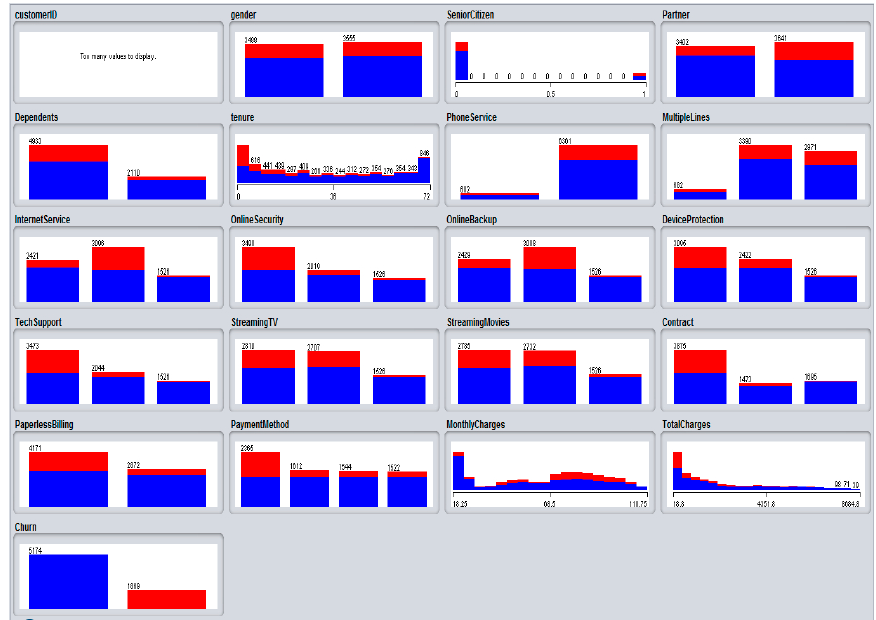
Figure 2. The distribution of attributes in churn dataset; Here red indicates churn customers while blue indicates non-churn customers. The figure is derived from Weka software [72].